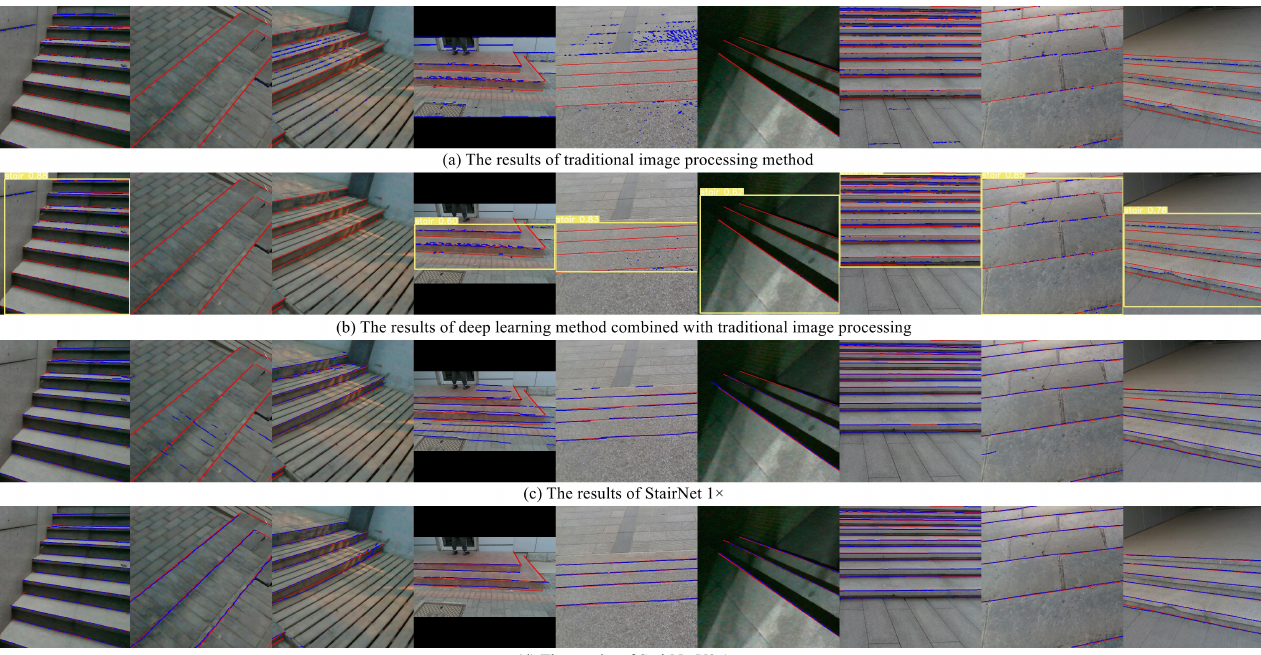
Figure 8. Visualization of the comparison experiments. The red line shows the ground truth and the blue line shows the predicted